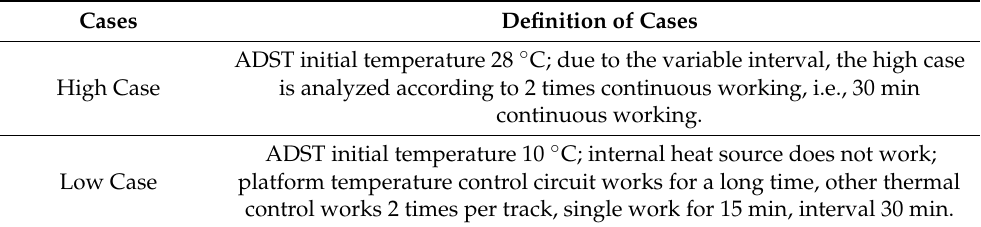
Table 1. Definitions of high- and low-temperature cases for the ADST. Cases